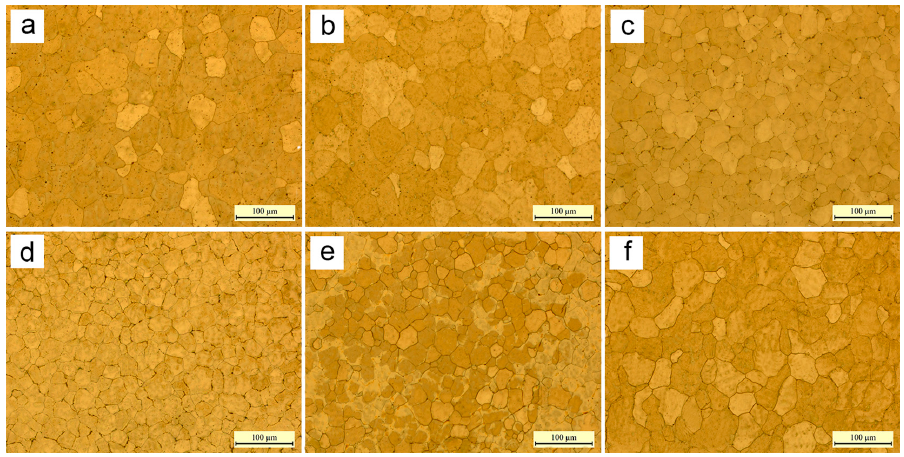
Figure 8. Microstructures of the samples deposited by different pulse frequencies: ( a ) 500 Hz; ( b ) 100 Hz; ( c ) 10 Hz; ( d ) 5 Hz; ( e ) 2 Hz and ( f ) 1 Hz.